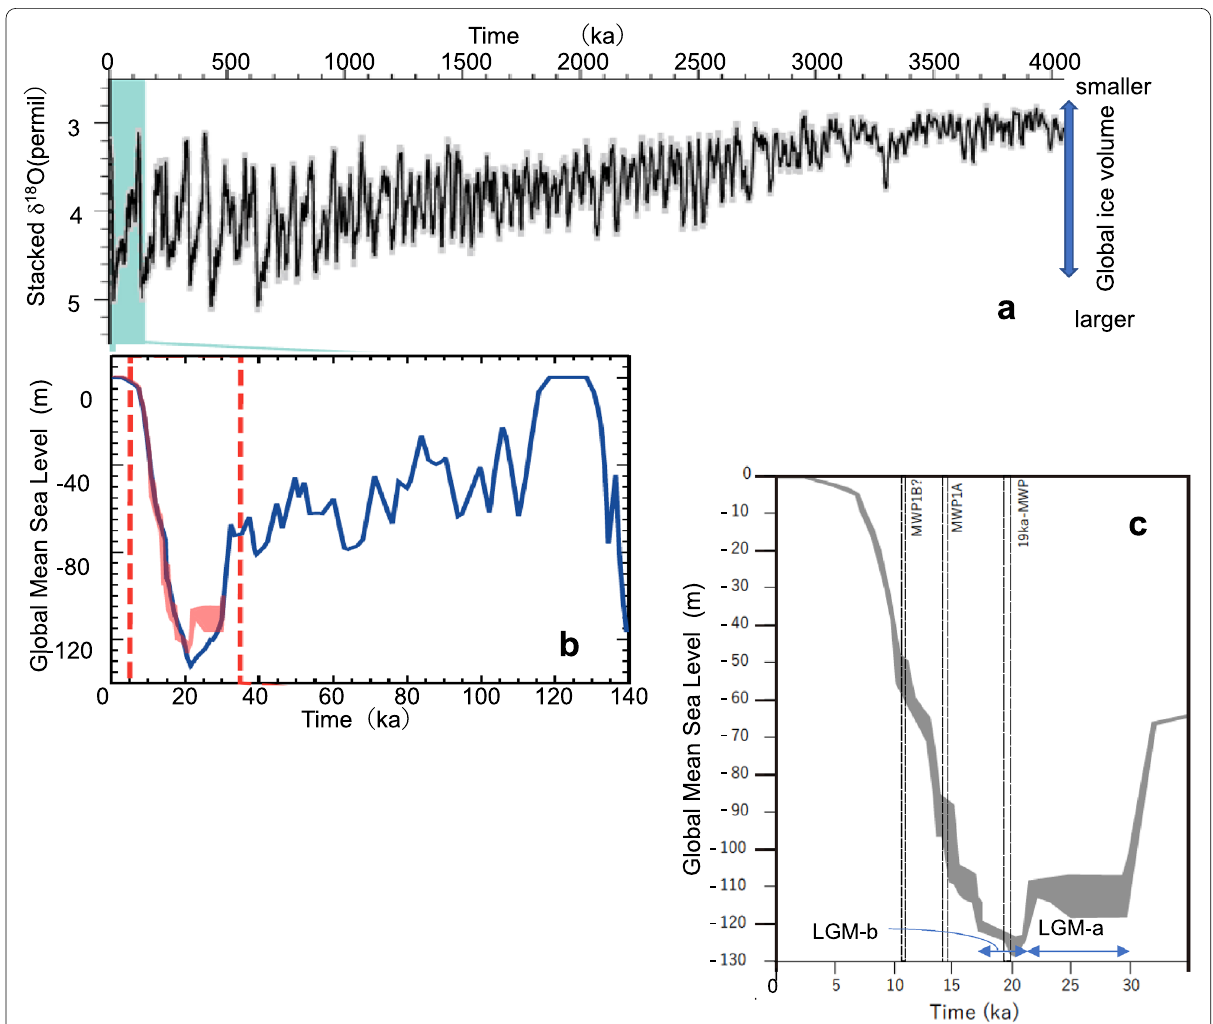
Fig. 3 Sea-level record from the last 5.5 Million years. The long-term record is produced by an indirect method, namely δ 18 O obtained from deep sea sediments (Lisiecki and Raymo 2005). The sea level since the last interglacial is reconstructed based on direct methods, such as corals ( b ). The last 35 ka of detailed sea level reconstructions using data obtained from Northeastern and Northwestern Australia is depicted in ( c ). Rapid rises and falls of sea level can be identified (Yokoyama et al. 2018; Webster et al. 2018; Ishiwa et al.